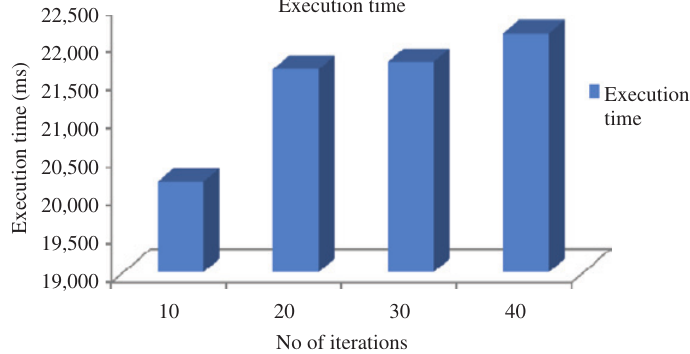
Figure 5: Execution Time for the Proposed Technique.